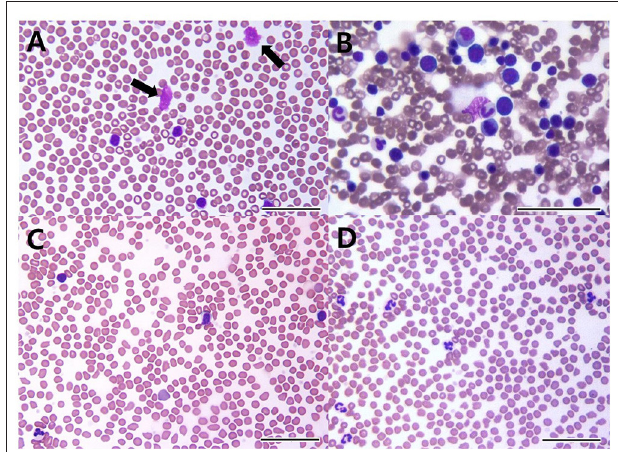
FIGURE 1 | Peripheral blood (A,C,D) and bone marrow cytology (B) in a dog with B-cell chronic lymphocytic leukemia. On the first visit, cytology shows increased well-differentiated lymphoid cells in peripheral blood (A) and the bone marrow (B) . Smudge cells (black arrows) are seen in peripheral blood (A) . 22 days after initial treatment (C) , cytology reveals lymphocytosis despite administration of prednisolone and chlorambucil. After 1 year of multimodality therapy with additional administrations of imatinib, leukocytosis and lymphocytosis are resolved (D) [ (A–D) : bar = 50 µ m].